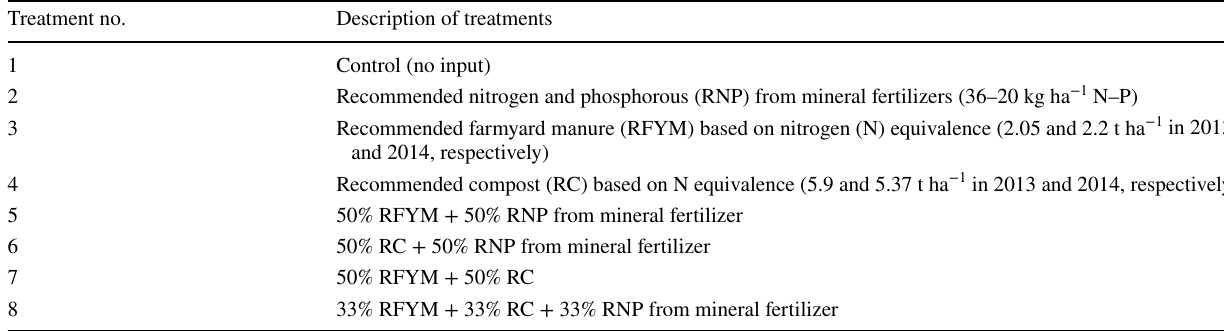
Table 2 Treatment setup for 2013 and 2014 cropping seasons Treatment